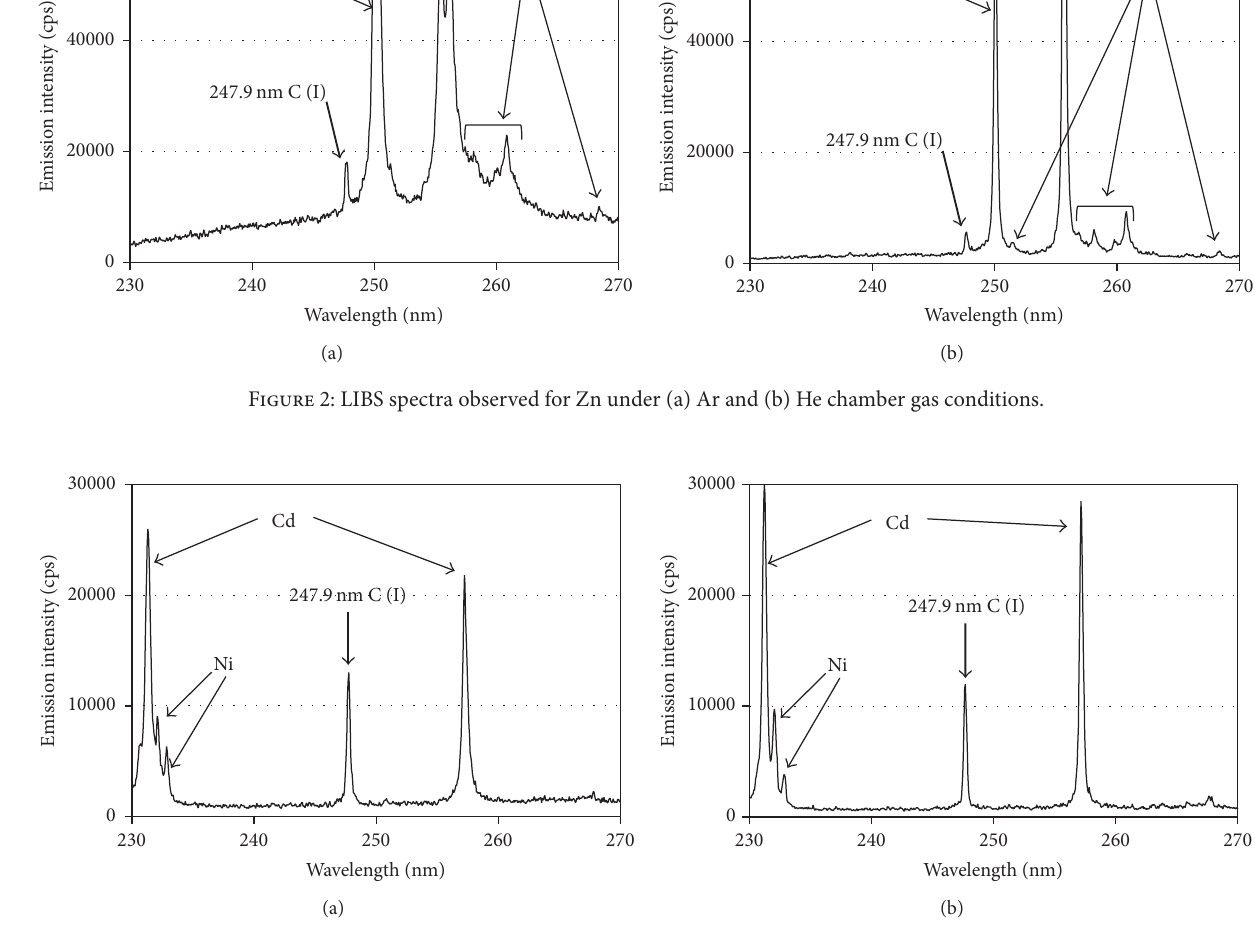
Figure 3: LIBS spectra observed for Cd under (a) Ar and (b) He chamber gas conditions.